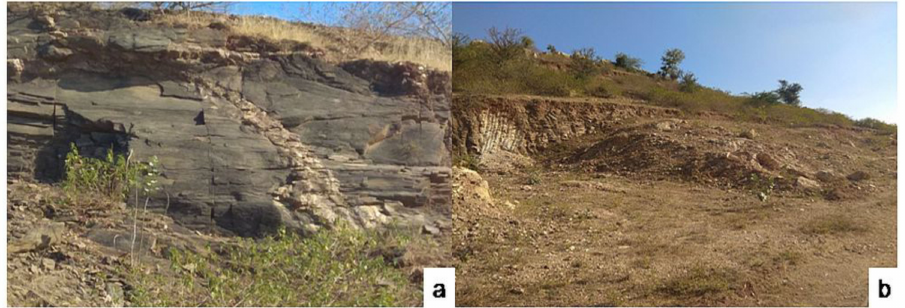
Figure 9. ( a ) Pegmatitic or silicic intrusion within the BMQ thin section near Gurla. ( b ) Surface exposures of sericitized altered rock associated with the pegmatite intrusion in the Gurla area as shown in the Figure